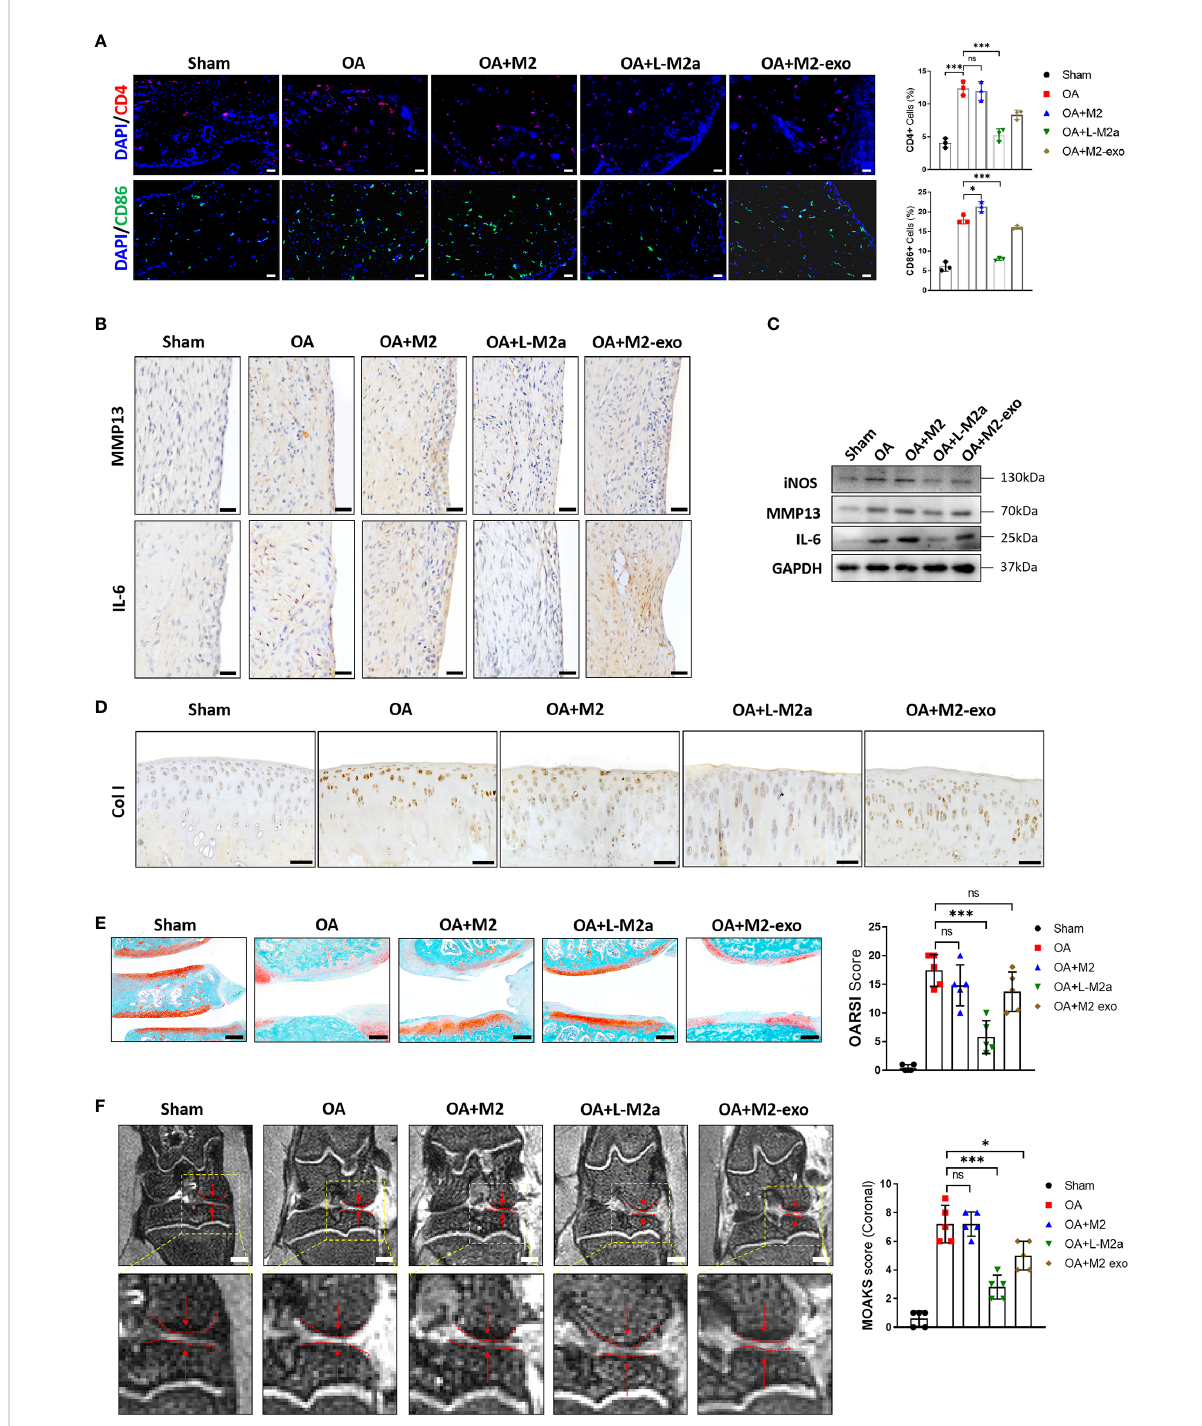
FIGURE 6 L-M2a M j s promoted OA repair in a rat OA model. (A) Immuno fl uorescence of CD4+ (red) and CD86+ (green) cells and DAPI staining (blue) in Sham, OA, M2, L-M2a, and M2-exo groups at 4 weeks after injection (n=3, bar= 100 m m). (B, C) Immunohistochemical staining (B, bar= 100 m m) and western blot (C) of IL-6, MMP13, and iNOS in synovium of rat joints. (D) Immunohistochemical staining of Col I in cartilage of rat joints. bar= 100 m m. (E) Safranin O/fast green staining of cartilage (left) and OARSI score (right) (n=5, bar=500 m m). (F) Medial joint space (left, red arrow between two dotted lines) in coronal position of total knee and MOAKS score (right) by magnetic resonance imaging. (n=5, bar=1000 m m). ∗ p < 0.05; ∗∗∗ p < 0.001. ns, no signi fi cance; M j , macrophage; L-M2a M j , locked M2a macrophage; M2-exo, M2 macrophage